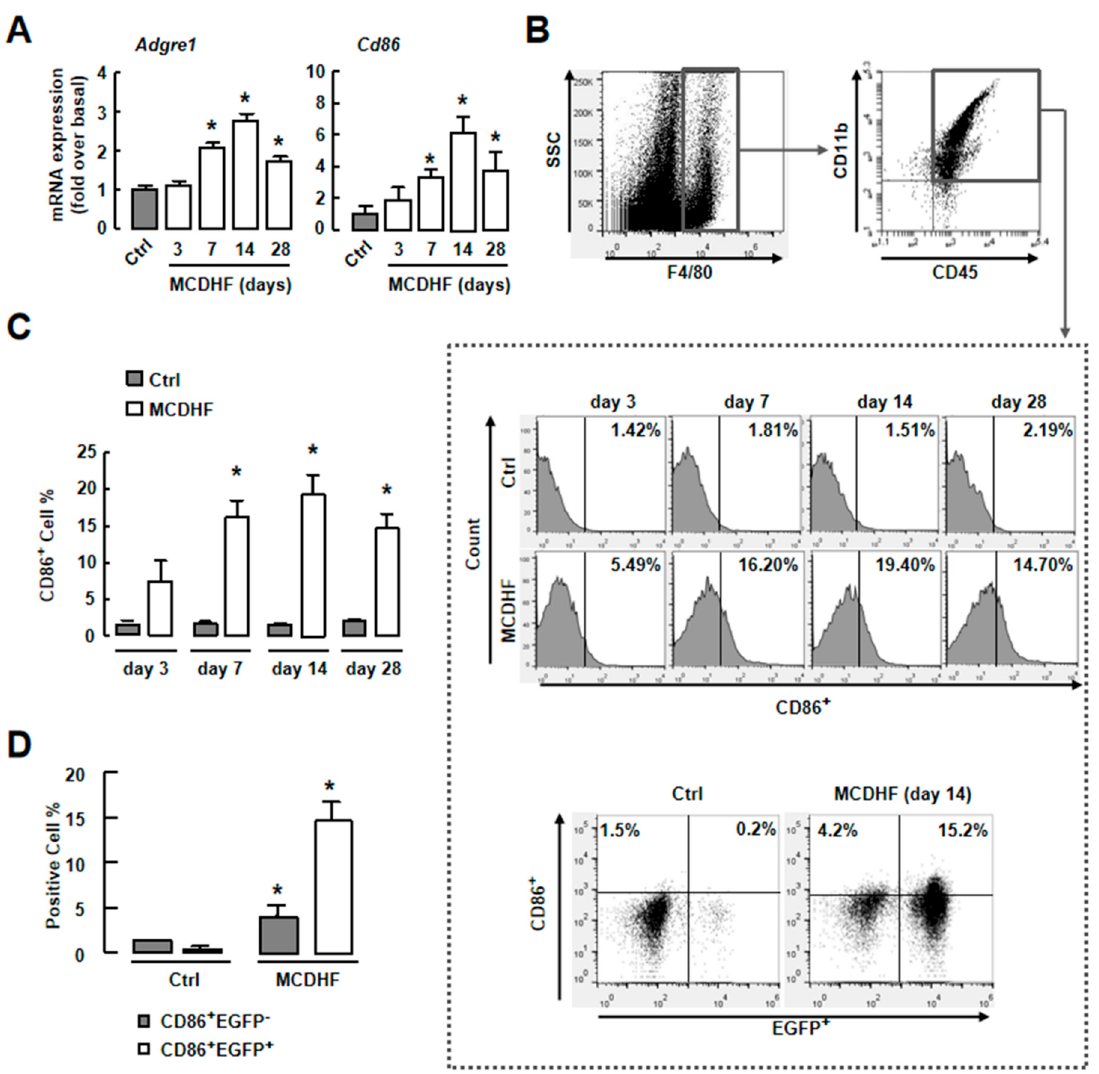
Figure 4. Increase of iM ϕ was associated with MCDHF-diet-induced liver injury in vivo. ( A ) The mRNA expressions of F4 / 80 ( Adgre1 ) and CD86 in the liver of MCDHF-diet-treated mice were determined by RT-qPCR. ( B ) Liver NPCs were isolated and gated by CD45, CD11b, and F4 / 80 in the liver of MCDHF-diet-fed mice (up). The total number of iM ϕ (CD86 + ) was measured in the liver of MCDHF-diet-treated mice from day 3 to day 28 (middle). The number of pro-inflammatory BMMs and pro-inflammatory KCs were measured in the liver of BM-transplanted mice after 14 days MCDHF diet feeding (low). ( C ) Quantification of total iM ϕ . ( D ) Quantification of pro-inflammatory BMMs and pro-inflammatory KCs. Data are presented as the mean ± SEM. * p < 0.05 versus control group ( n = 6 for each group in each experiment).